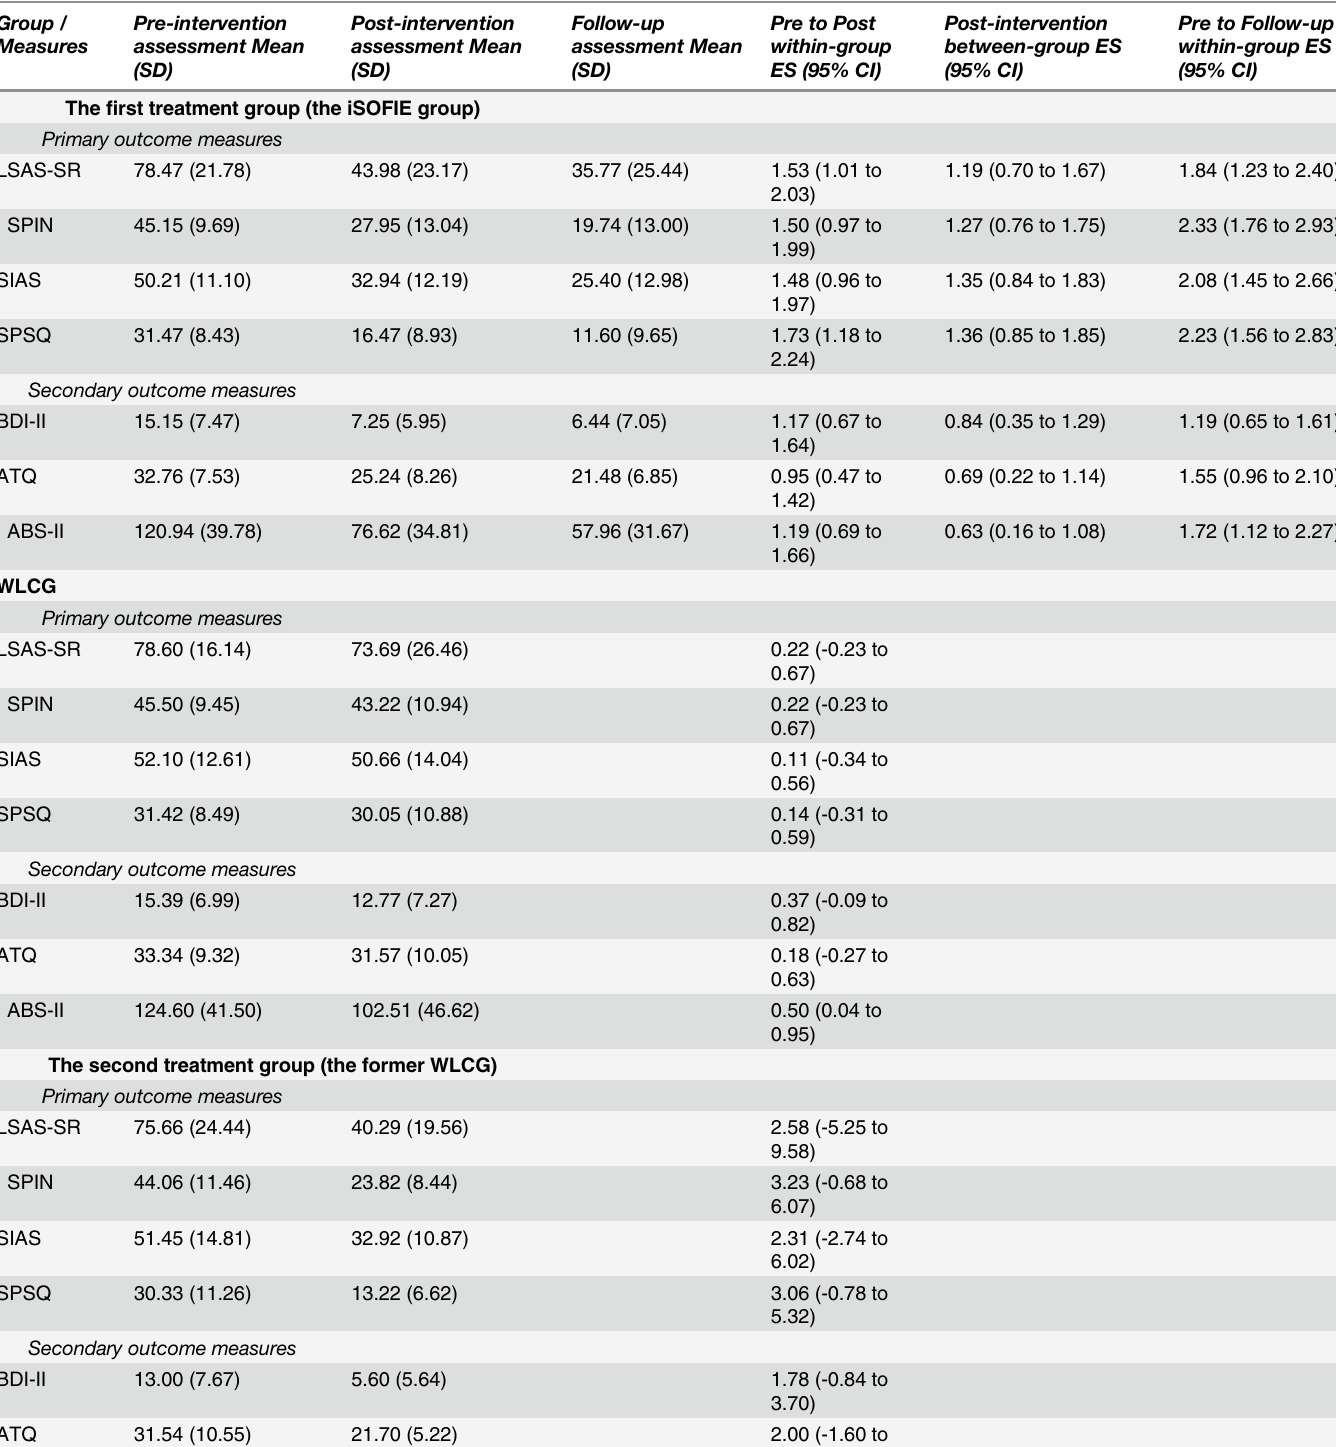
Table 4. Results of the two groups before and after the iSOFIE program (all